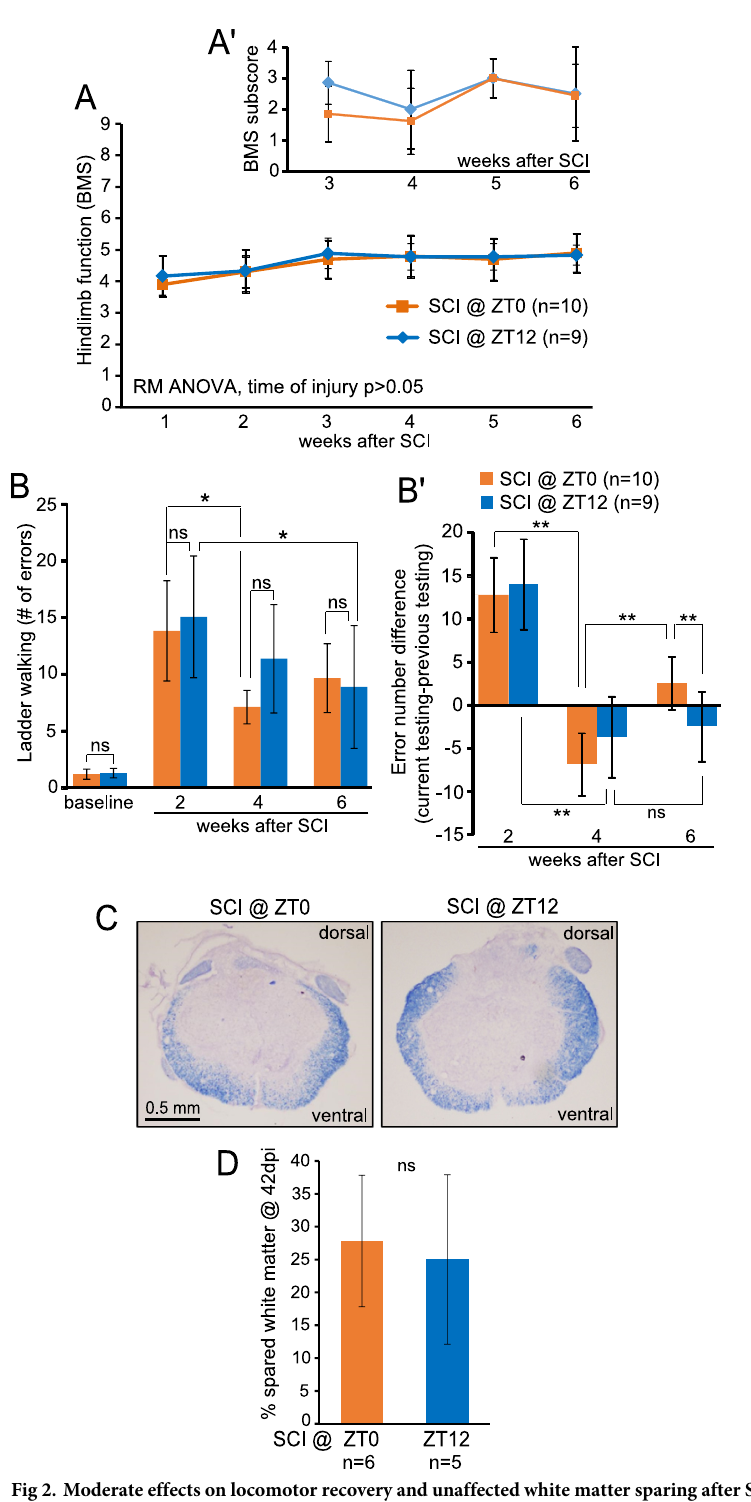
Fig 2. Moderate effects on locomotor recovery and unaffected white matter sparing after SCI at ZT0 or ZT12. A , B , Locomotor recovery after T9 50 kdyn IH contusion was quantified using the BMS (A and A’) or the horizontal ladder test (mean number of errors is shown in B and mean difference in number of errors between the current and the previous testing session is shown in B’; for week 2 post-SCI the pre-injury baseline served as a normalization reference). The surgeries were done 12 h apart and all the assessments were done at the same time. For either